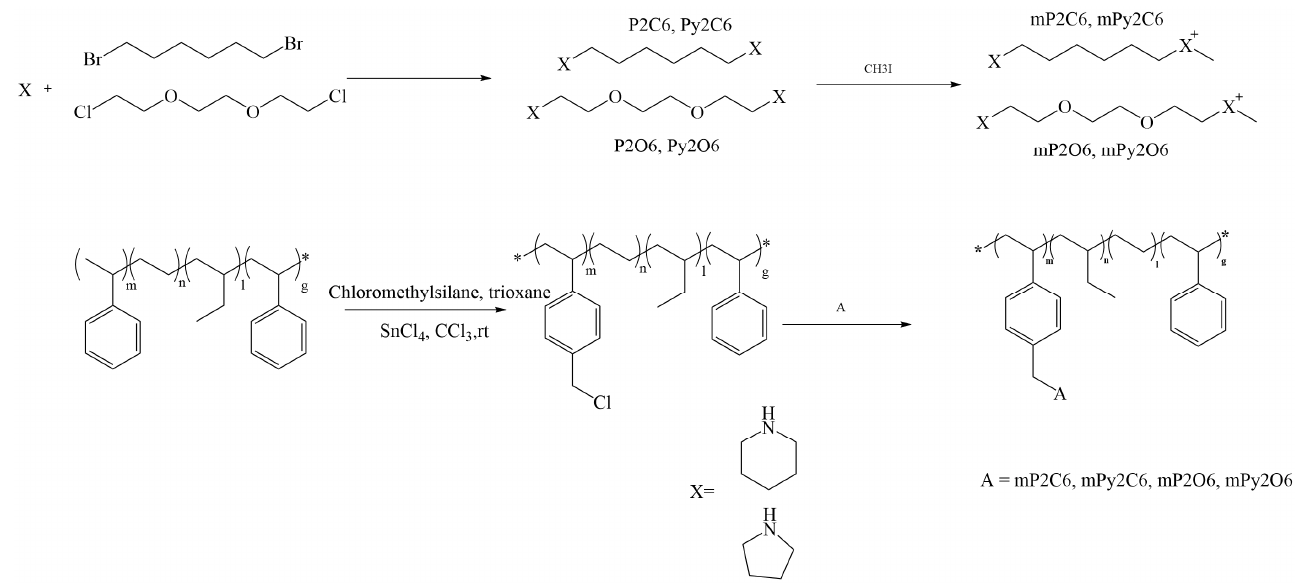
Figure 2. Different membranes structures obtained in this study: ( a ) SEBS-P2C6, ( b ) SEBS-P2O6, (c) SEBS-Py2C6, ( d )